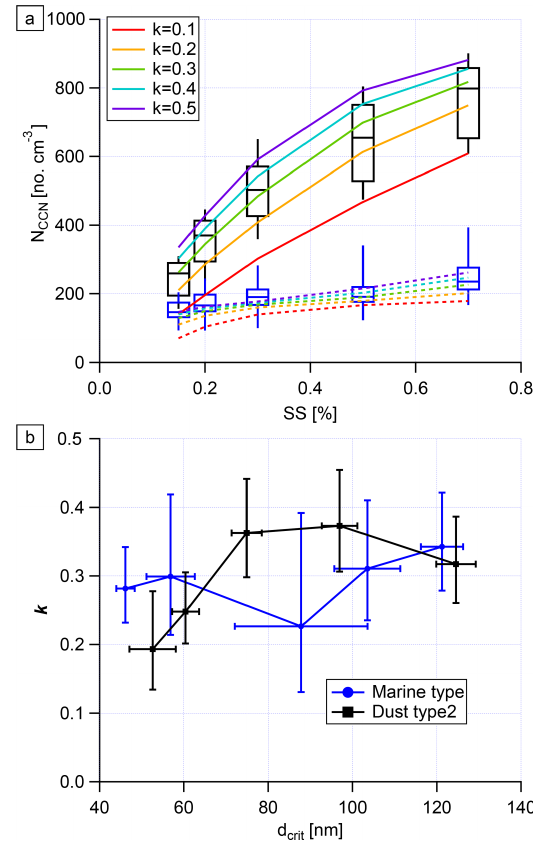
Figure 12. (a) Boxplots of N CCN as a function of κ for marine type (blue) and dust type2 (black). Whiskers show the 10th to 90th per- centiles. The predicted N CCN based on median PNSD and different κ values (0.1, 0.2, 0.3, 0.4 and 0.5) are shown in solid (during dust type2 period) and dashed lines (during marine period). (b) κ as a function of d crit for marine type (blue) and dust type2 (black). Er- ror bars of d crit and κ show 1 standard deviation and 1 geometric standard deviation,